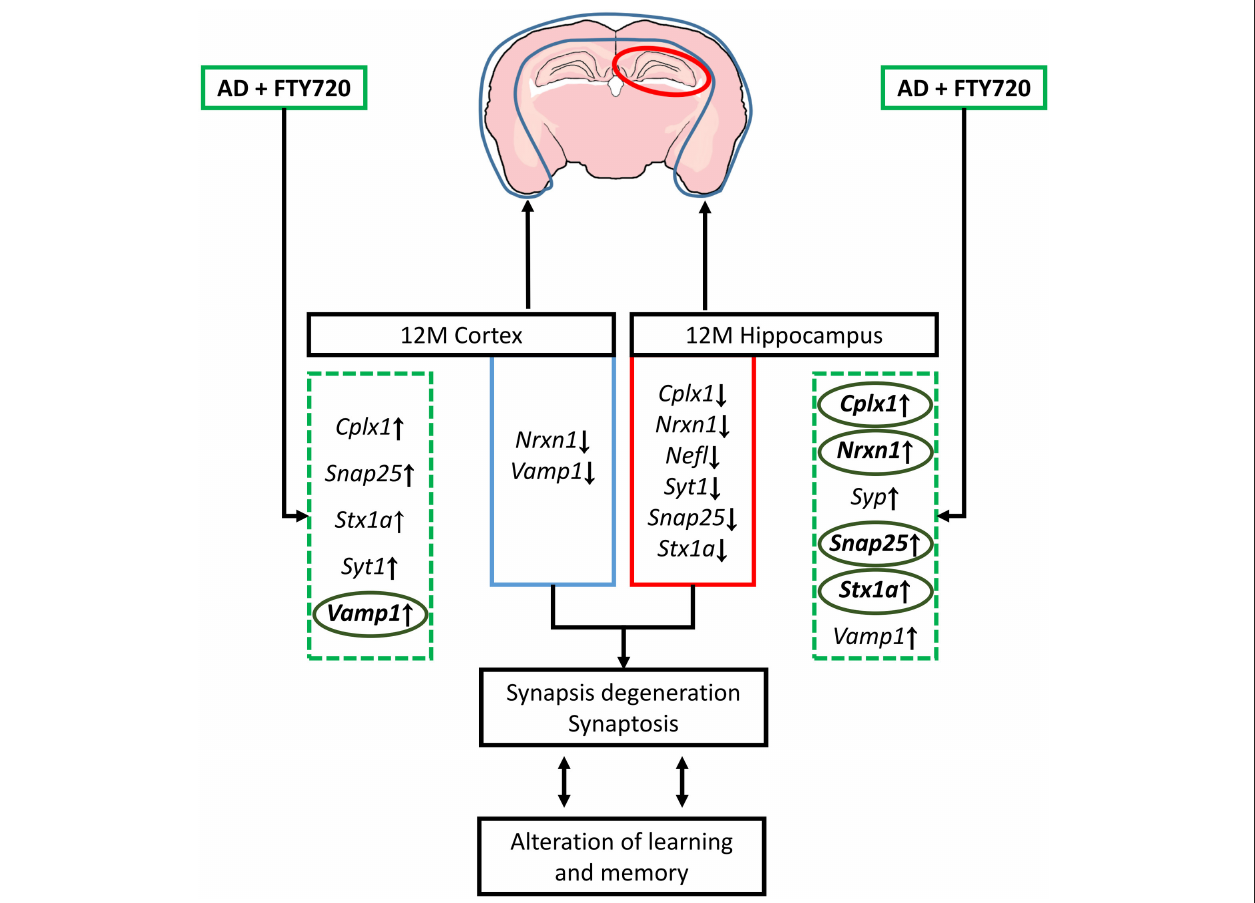
FIGURE 6 | Schematic representation of changes in genes coding synaptic proteins and their possible consequences observed in 12-month (12M) FVB/A β PP (V717I) mice cortex and hippocampus. The effect of fingolimod (FTY720, marked by green dashed square) on genes that expression was altered in AD mice brain was bolded and marked with circles (ellipses). Snap25 , synaptosomal-associated protein, 25kDa; Stx1a , syntaxin 1A; Vamp1 , vesicle-associated membrane protein 1; Nrxn1 , neurexin 1; Cplx1 , complexin 1; Syt1 , synaptotagmin 1; Syp , synaptophysin; Nefl , neurofilament